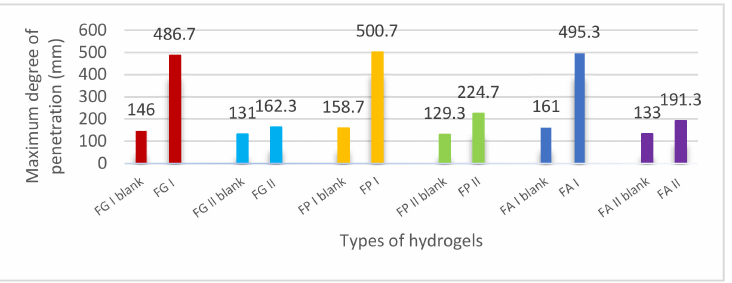
Figure 11. The influence of the formulation composition on the consistency of the studied experimen- tal